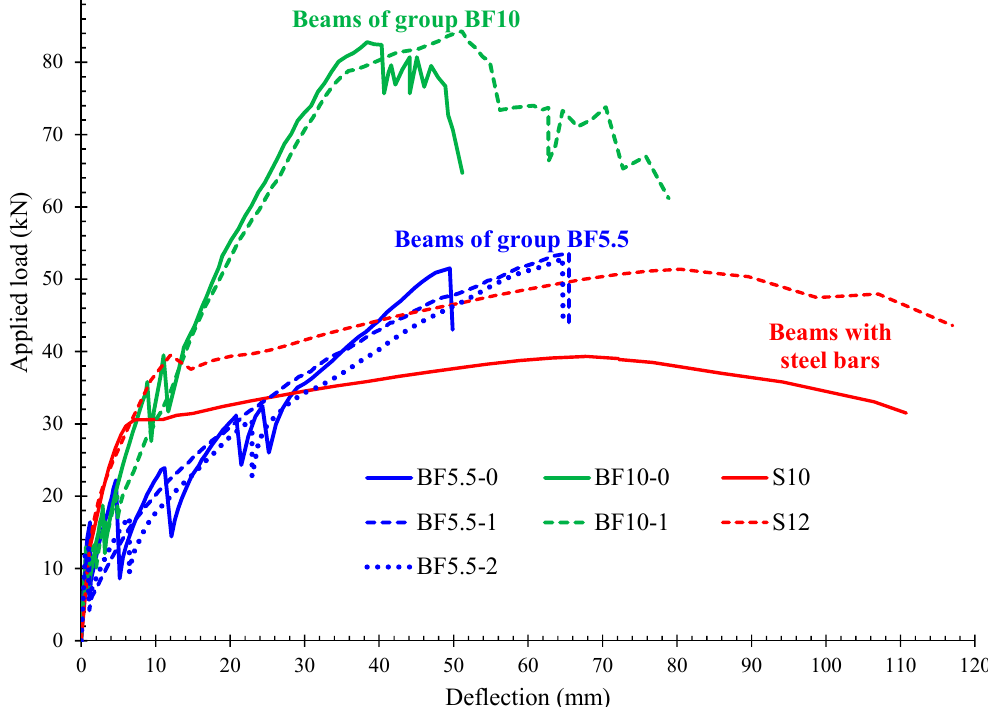
Figure 9. Comparison of the load to midspan deflection curves of the tested beams.